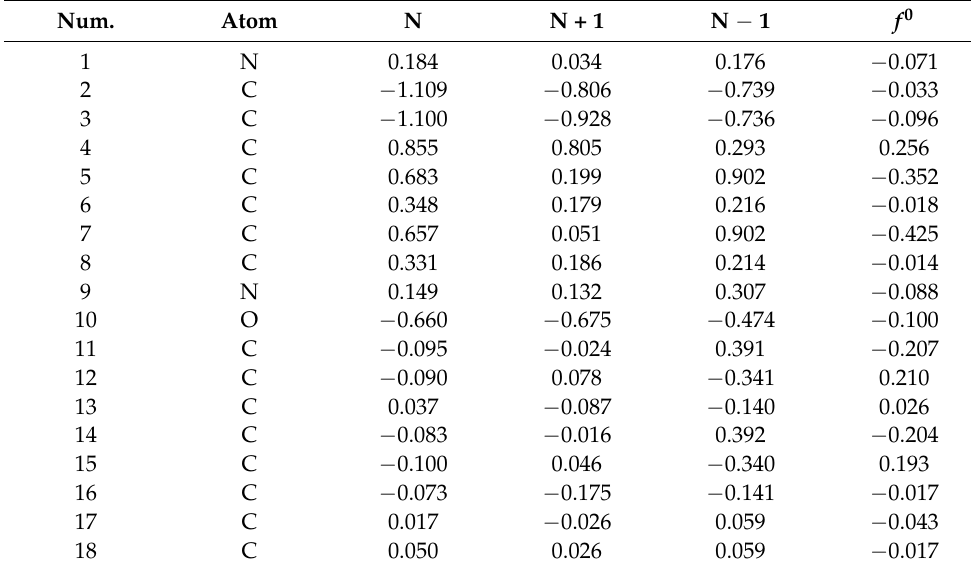
Table 2. Condensed Fukui index ( f 0 ) distribution by MPA on